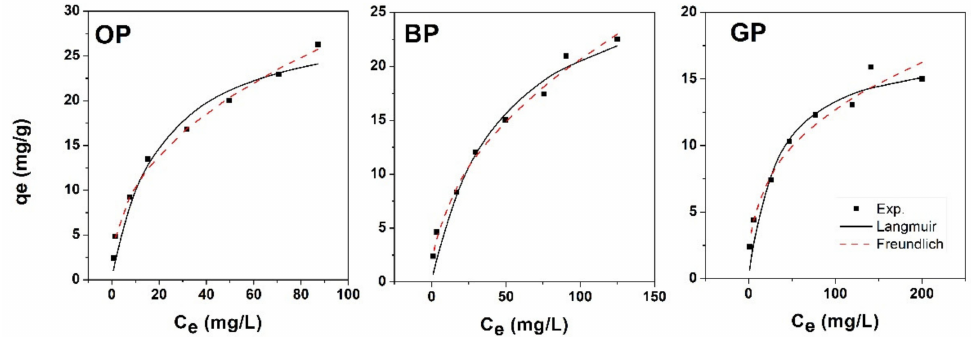
Figure 5. Zn(II) ion adsorption isotherms using chemically modified BP 0.8 , GP 0.8 , and OP 0.8 peel